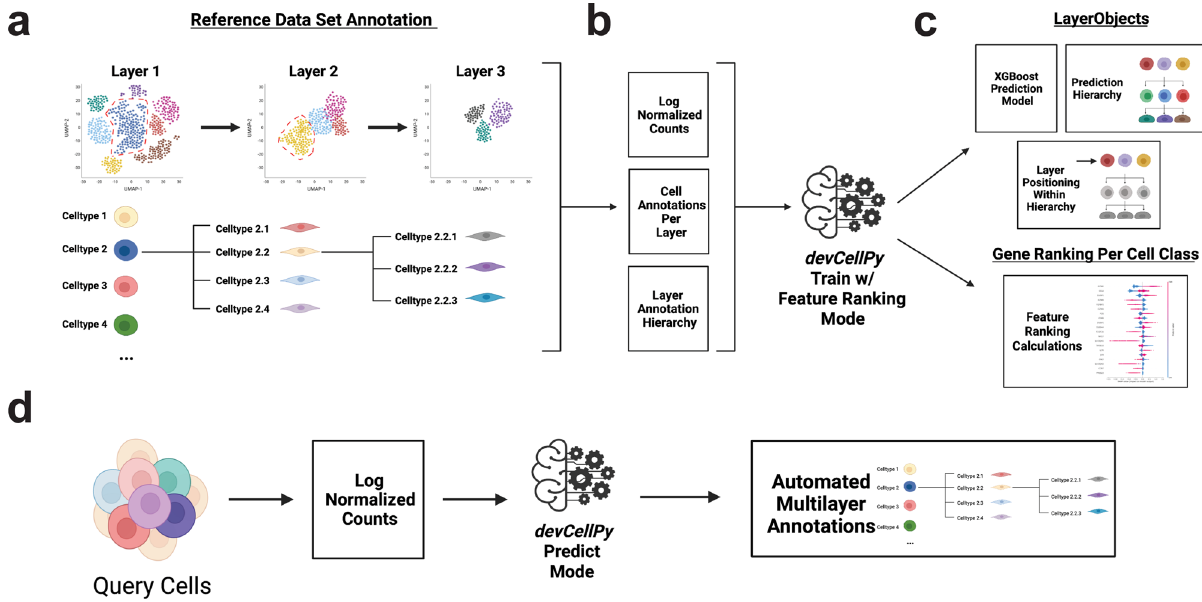
Fig. 1 | Overview of devCellPy . devCellPy is a multilayered machine learning algo- rithmforthehierarchicalannotationofsingle-cellRNA-seqdata. a Referencedatais constructedby conducting annotation ofthe dataset across multiple layers. These layers follow a hierarchical structure where cell subtype annotations are nested within broader categories. The hierarchical structure can be present for any com- bination of layers and sublayers. b To train devCellPy , log normalized counts, individual cell annotations per layer, and a layer annotation hierarchy are fed into the algorithm ’ s train mode. c devCellPy will create a LayerObject for each layer of annotation within the hierarchy. The LayerObject consists of an XGBoost predic- tionmodelthatistrainedonthereferencedataandwillalsoencodethepositionof